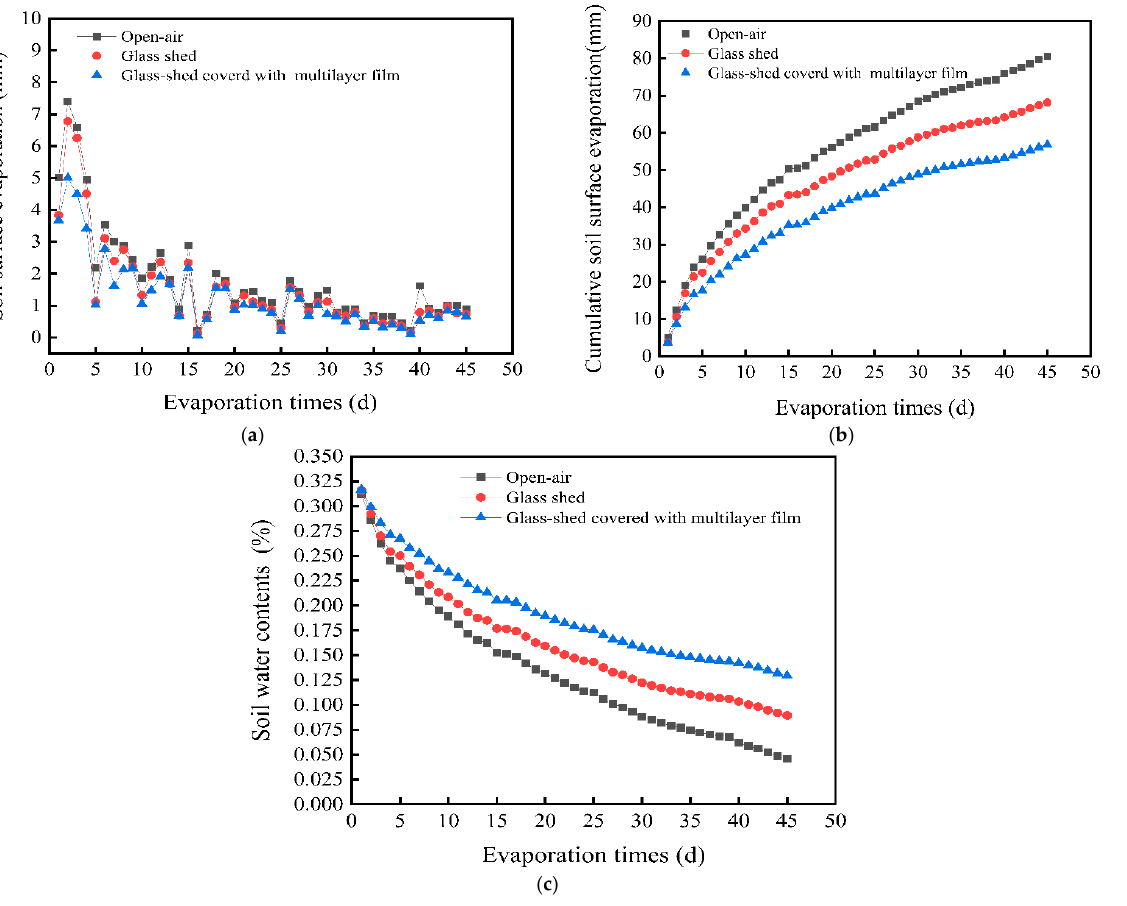
Figure 4. The effect of three treatments on the evaporation of water from the soil surface is ( a ) soil surface evaporation of each day (mm), ( b ) cumulative soil surface evaporation (mm), and ( c ) soil water content (%).